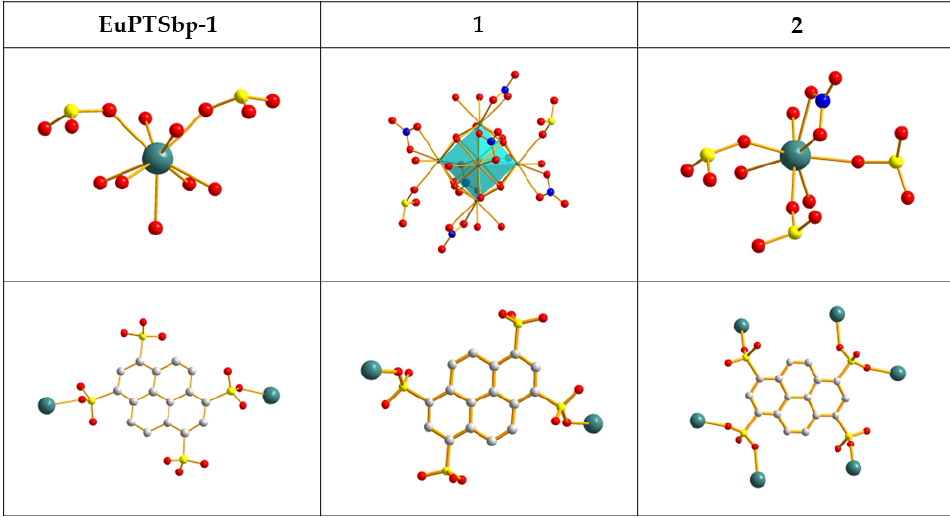
Figure 8. The coordination modes of Eu(III) ions and of pyrene tetra-sulfonic acid ligands in three different Eu-PTS MOCPs. Jasper: Eu; Red: O; Yellow: S; Blue: N; Offwhite: C (hydrogen atoms are omitted for clarity).